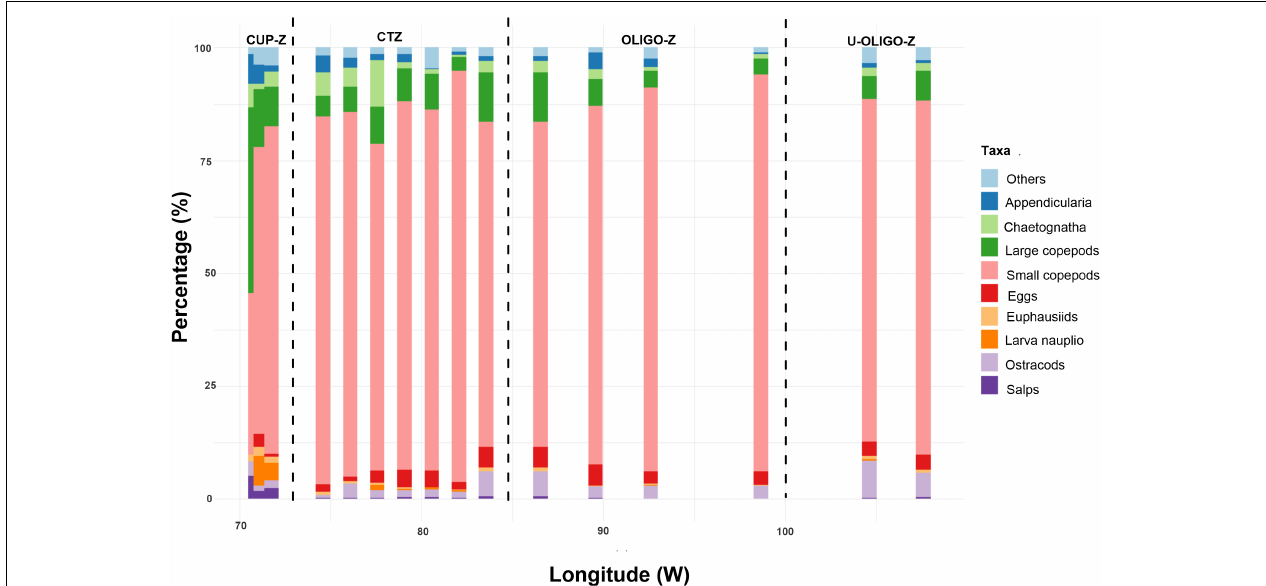
FIGURE 6 | Variation in relative abundance (%) of the most abundant taxonomic categories sampled during the cruise CIMAR-21 from the Chilean coast to Easter Island for a depth strata 0–200 m. The taxonomic categories were assessed by automated analysis (ZooScan). Four study zone were defined: CUP-Z, CTZ, OLIGO-Z and